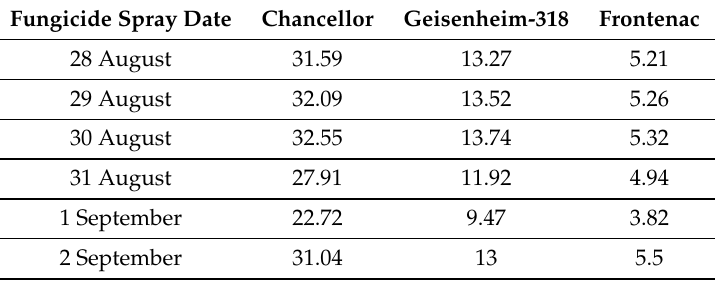
Figure 13. 3D plot of the fungicide spray strategies of Chancellor (upper-left), Geisenheim-318 (upper-right), and Frontenac (lower-center) from the forecast model on 27 August 2011 for six fungicide spray dates and corresponding 10-day DI based on the 16-day Global Ensemble Forecast System (GEFS) reforecast climate input. (Lower-right) 2D plot of the 10-day daily DI of the optimal spray date for Chancellor (dotted line); Geisenheim-318 (dot-dash line); and Frontenac (long-dash line) based on DI on 27 August 2011 and 16-day GEFS input. The solid line indicated the daily cumulative total precipitation from GEFS on 28 August 2011. Note: Darker color indicates higher disease severity. Table 5. DI values for the forecast model-based fungicide spray program on 27 August